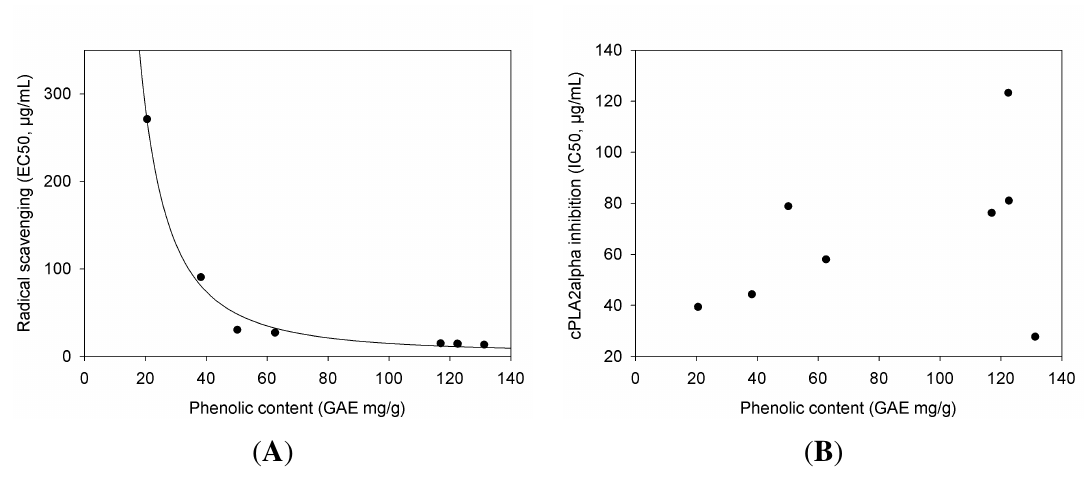
α inhibition with the phenolic Figure 3. Correlation of antioxidant activities and cPLA 2 content of the extracts. In ( A ), the EC values of radical scavenging (µg/mL extract 50 concentration, y-axis) are plotted against the phenolic content (GAE mg/g, x-axis). The non-linear regression curve is calculated with SigmaPlot (polynomial, inverse second order, simplified), resulting in the following equation: DP P H scavenging = 3 . 6+ 1 . 1 · 10 5 ; phenolic content 2 α inhibition (µg/mL extract concentration, y-axis) plotted ( B ) The IC values of cPLA 2 50 against the phenolic content (GAE mg/g, x-axis). The values do not reveal a correlation. α inh. (IC ( A ): DPPH (EC ) vs. phenolic content; ( B ): cPLA ) vs. phenolic 2 50 50